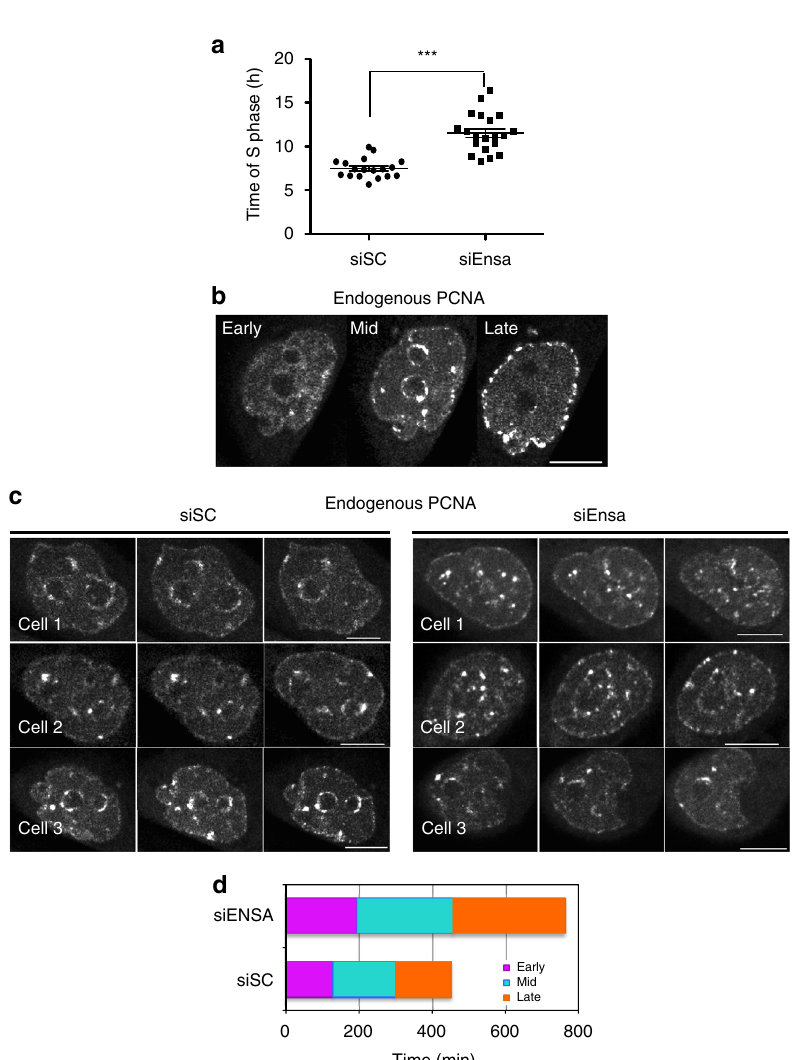
Fig. 4 Depletion of Ensa extends S phase without signi fi cantly altering the overall spatiotemporal patterns of replication. a HeLa chromobody cells were transfected with SC and Ensa siRNA and imaged by time-lapse microscopy for 72 h and S-phase duration visualised by GFP-nanobody-dependent staining of PCNA, recorded and represented as scatter dot blot ( n = 18 for siSC and n = 20 for siEnsa). Two-tailed unpaired Student ’ s t -tests was performed to determine the statistical relevance *** p < 0.0001. Data pooled from three biological replicates. b Representative images of early, mid and late replication factories from HeLa chromobody control cells used for time-lapse microscopy. Scale bar , 10 μ m. c Representative images of mid-replication origins from Supplementary Movies 1 – 6. Images corresponding to three Z -planes of three scramble and three siEnsa-treated HeLa cells stably expressing a chromobody directed to PCNA. Plans correspond to 4 h, 3 h 20 min and 4 h 15 min time points after DNA replication started in siSC-treated cells 1, 2 and 3 and to 5 h 15 min, 5 h 15 min and 6 h 50 min time points in siEnsa-treated cells 1, 2 and 3 from movies on supplementary data. Scale bar , 10 μ m. d HeLa chromobody cells treated as in c were imaged by time-lapse microscopy and the length of the early, mid and late S-phase patterns was recorded and represented as a bar